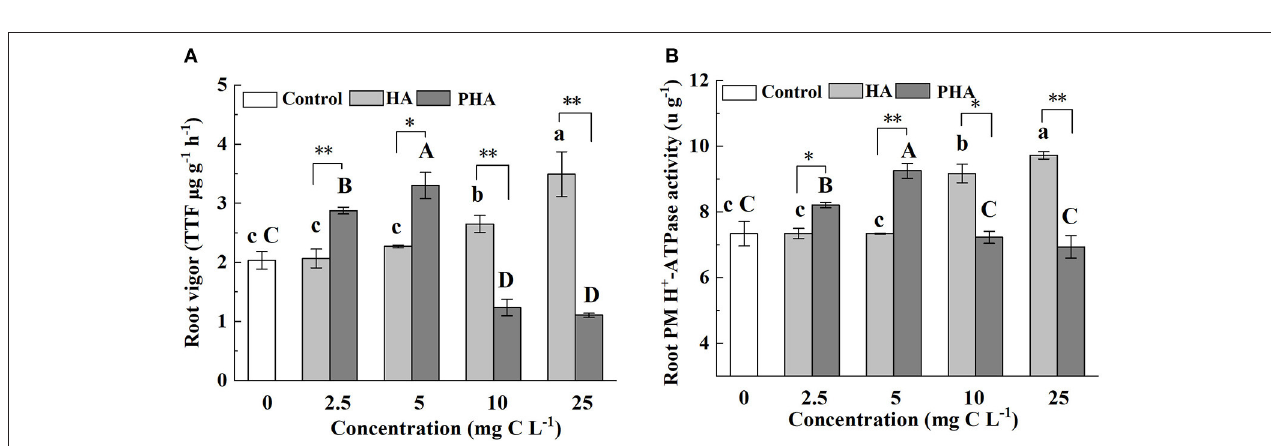
FIGURE 4 | Effects of 2.5–25mg C L − 1 of HA and PHA on (A) root vigor and (B) root plasma membrane (PM) H + -ATPase activity. Different lowercase letters above the column indicate significant differences between HA and control treatments, while different capital letters above the column indicate significant differences between PHA and control treatments at P < 0.05, as determined by the LSD test. Significant differences between HA and PHA treatments at equivalent carbon concentrations were compared with two independent sample t- tests, * P < 0.05; ** P <